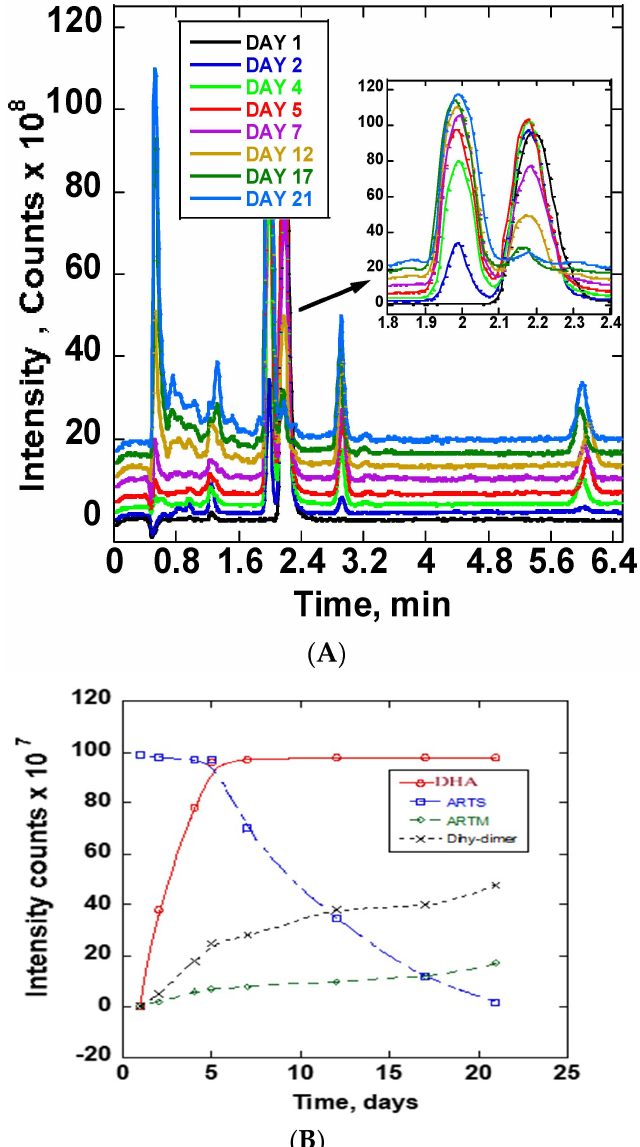
Figure 4. ( A ) Daily TIC chromatograms of ARTS reaction in 20 mM ammonium acetate: methanol obtained at room temperature and at 37 °C. ( B ) Peak intensity as a function of time (days) for chromatographic peaks representing DHA, ARTS, ARTM and DHA dimers.